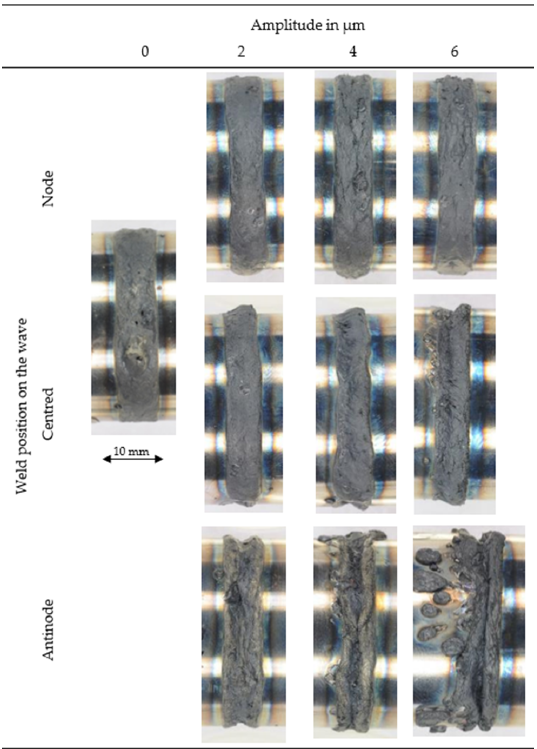
Figure 4. Visual inspection of 2.4856 weld seams, depicted side opposite to welding start/end point.